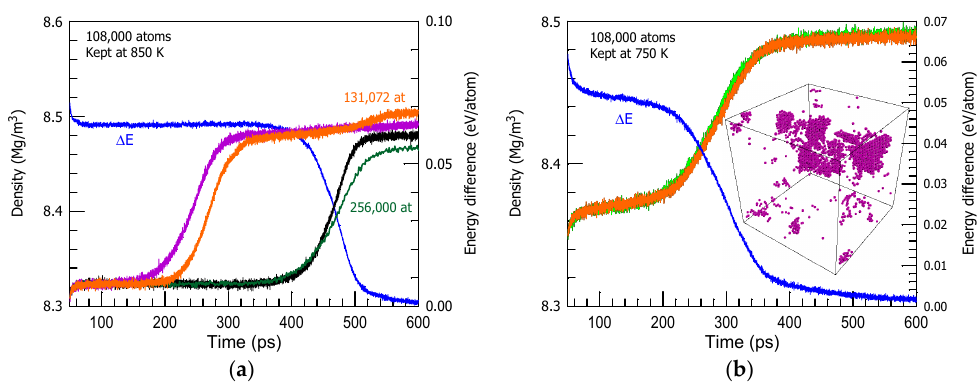
Figure 4. Density change as a function of time for pure Cu at 850 K ( a ) and 750 K ( b ) for 108,000 atoms per cell. ( b ) also indicates the energy difference ( Δ E ) in blue for one plot. The insert indicates the atomic cell at 270 ps with atoms belonging to FCC clusters only. The initial 50 ps are related to heating, melting and cooling time.